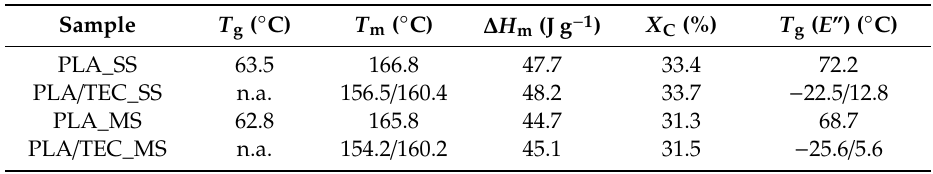
Thermal data obtained by DSC and dynamic mechanical thermal analysis (DMTA) measurements for PLA and PLA / TEC